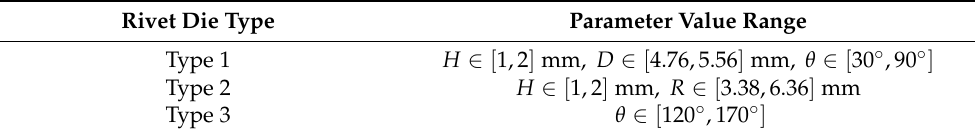
Figure 2. The structural sketch of different types of rivet die. Table 3. The parameter value range.